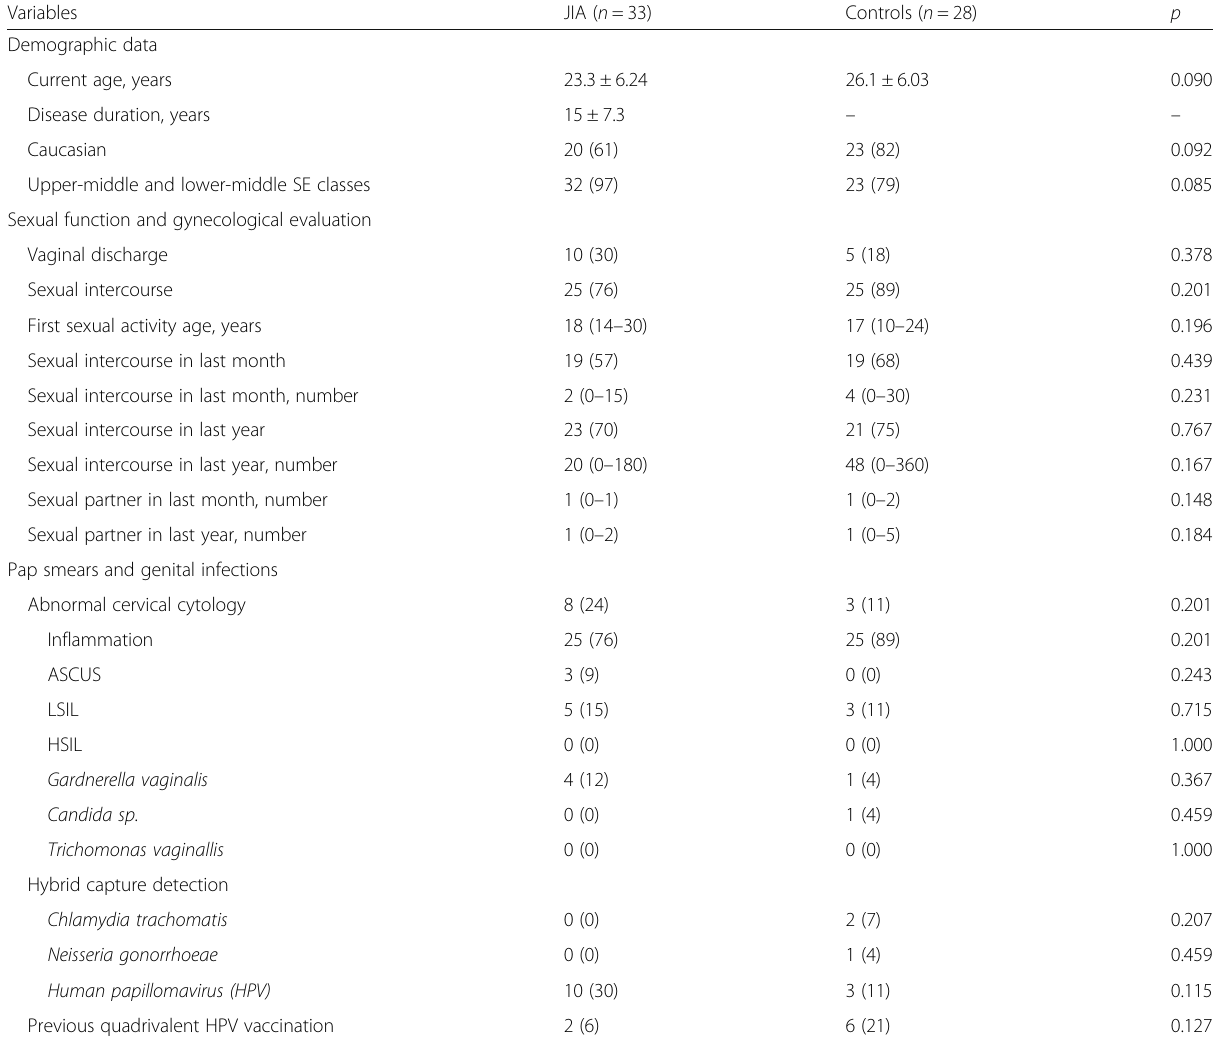
Table 2 Demographic data, sexual function, gynecological evaluation, Pap smears, genital infections and HPV vaccination in juvenile idiopathic arthritis (JIA) patients and healthy